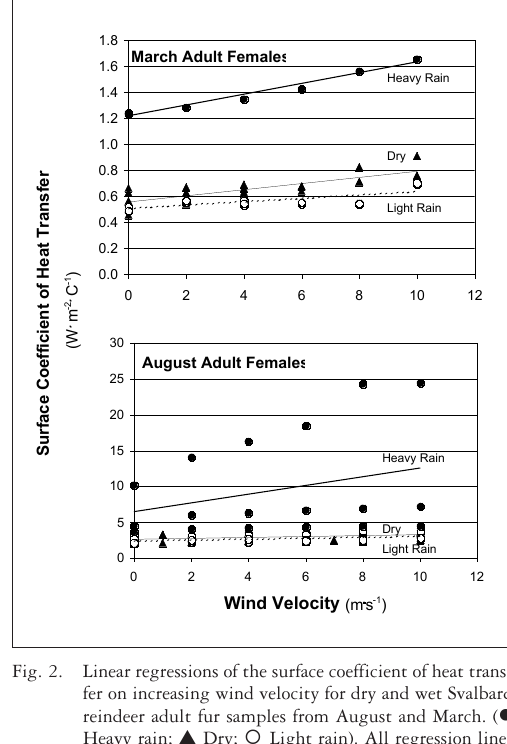
Fig. 2. Linear regressions of the surface coefficient of heat trans- fer on increasing wind velocity for dry and wet Svalbard reindeer adult fur samples from August and March. ( l Heavy rain; ▲ Dry; ° Light rain). All regression lines are calculated and drawn by Microsoft